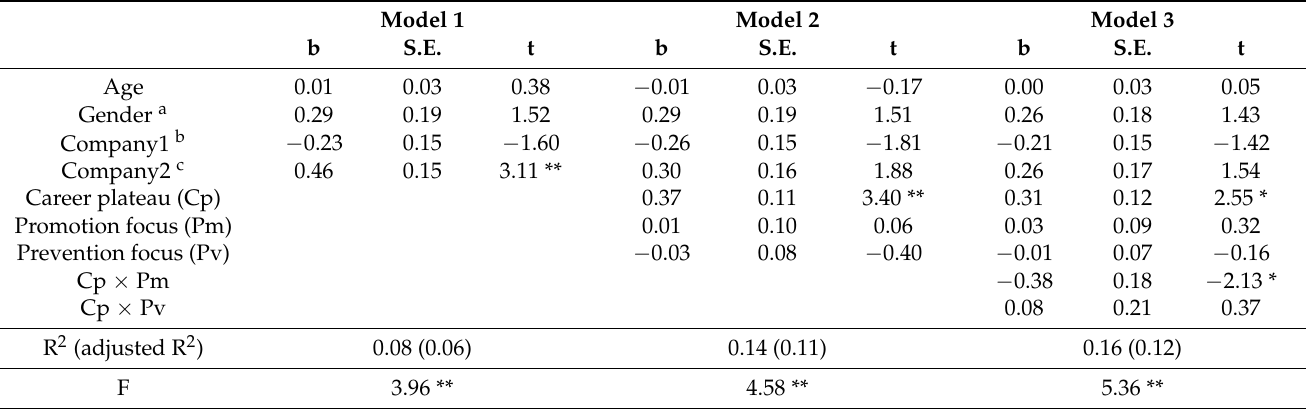
Table 4. Regression estimates for job burnout.